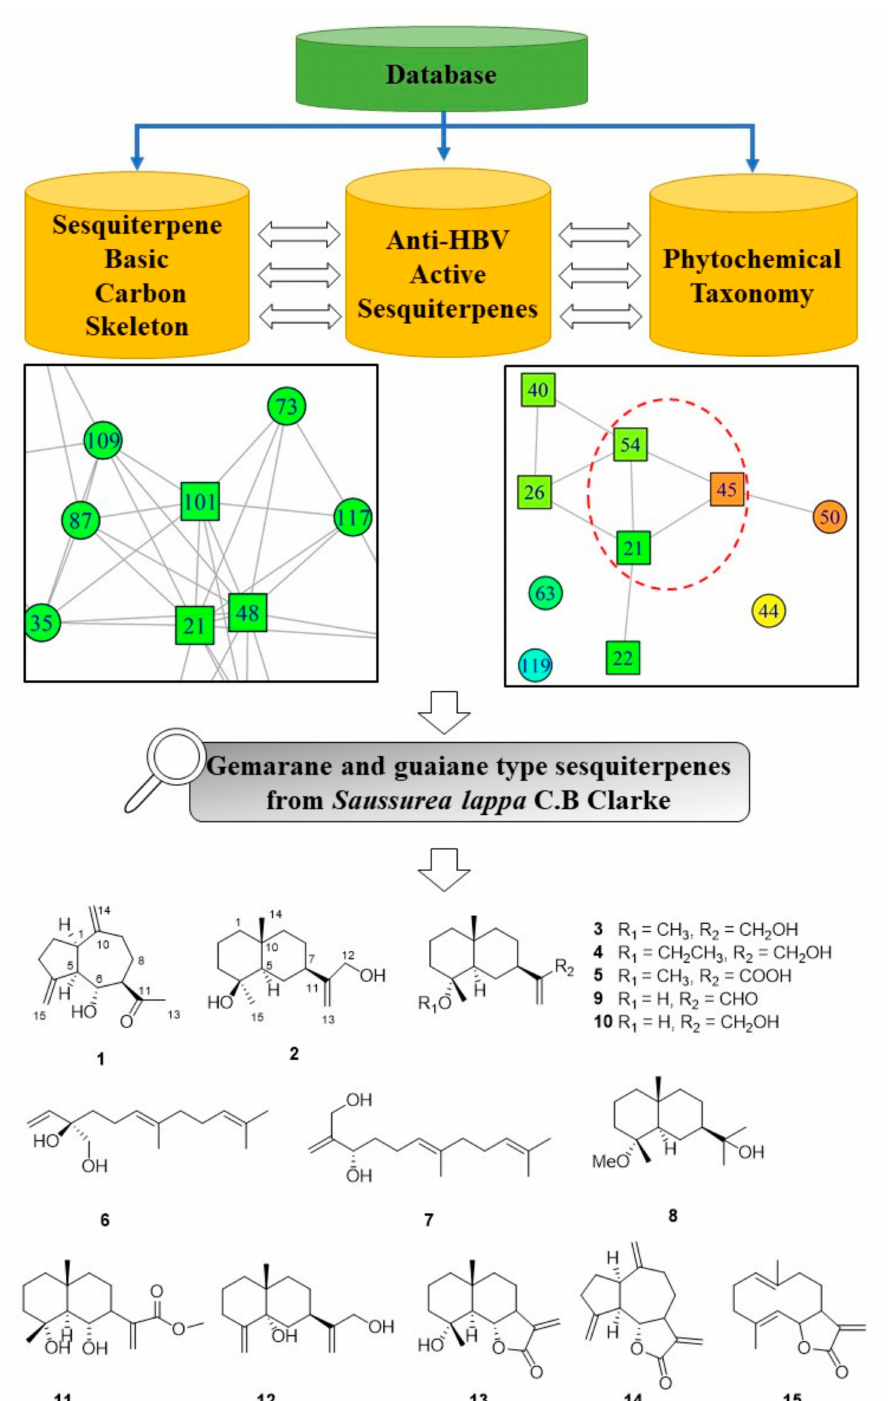
Figure 2. New Compounds 1 – 15 from the roots of S. lappa